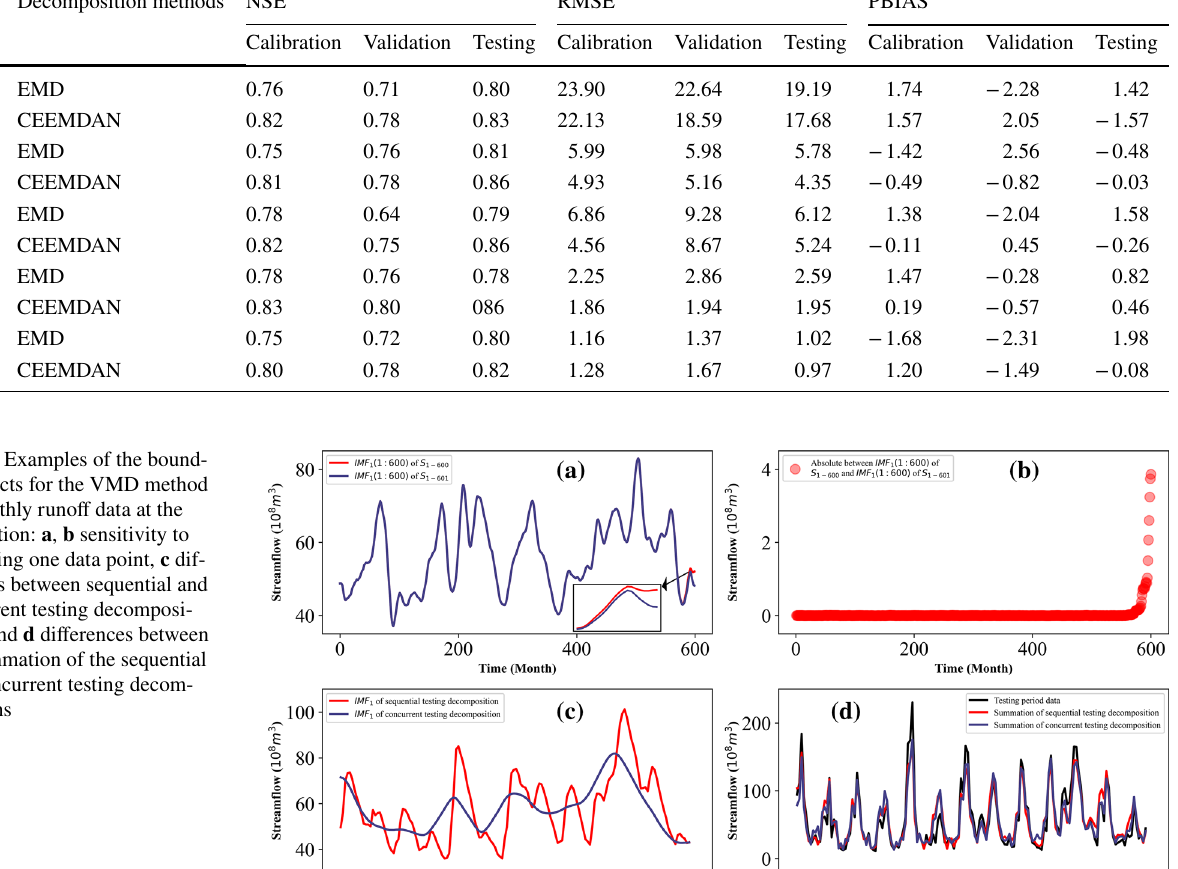
Table 1 Performance criteria for EMD- and CEEMDAN-based models developed using OD sampling technique Station Decomposition methods NSE